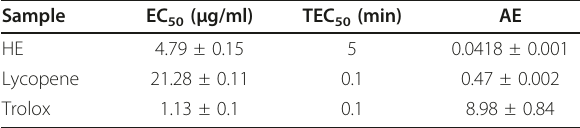
Table 1 Yield of the different solvent extractions of A. lappa root Extract Yield Dichloromethane hot extract 0.12% Ethanolic hot extract 6.39% Aqueous hot extract 2.87% Dichloromethanic extract 0.10% Ethanolic extract 4.45% Aqueous extract 3.51% Total aqueous extract 10.56% Hydroethanolic extract 10.25%